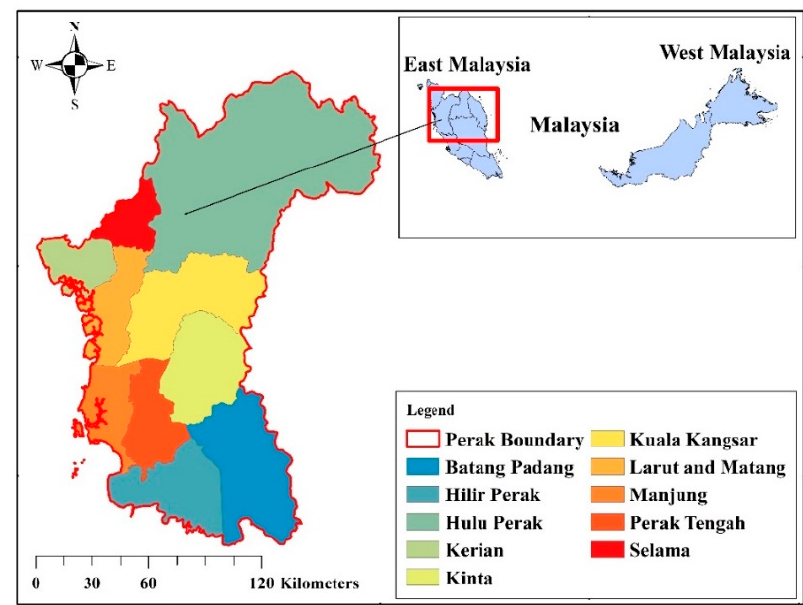
Figure 1. Description of the study